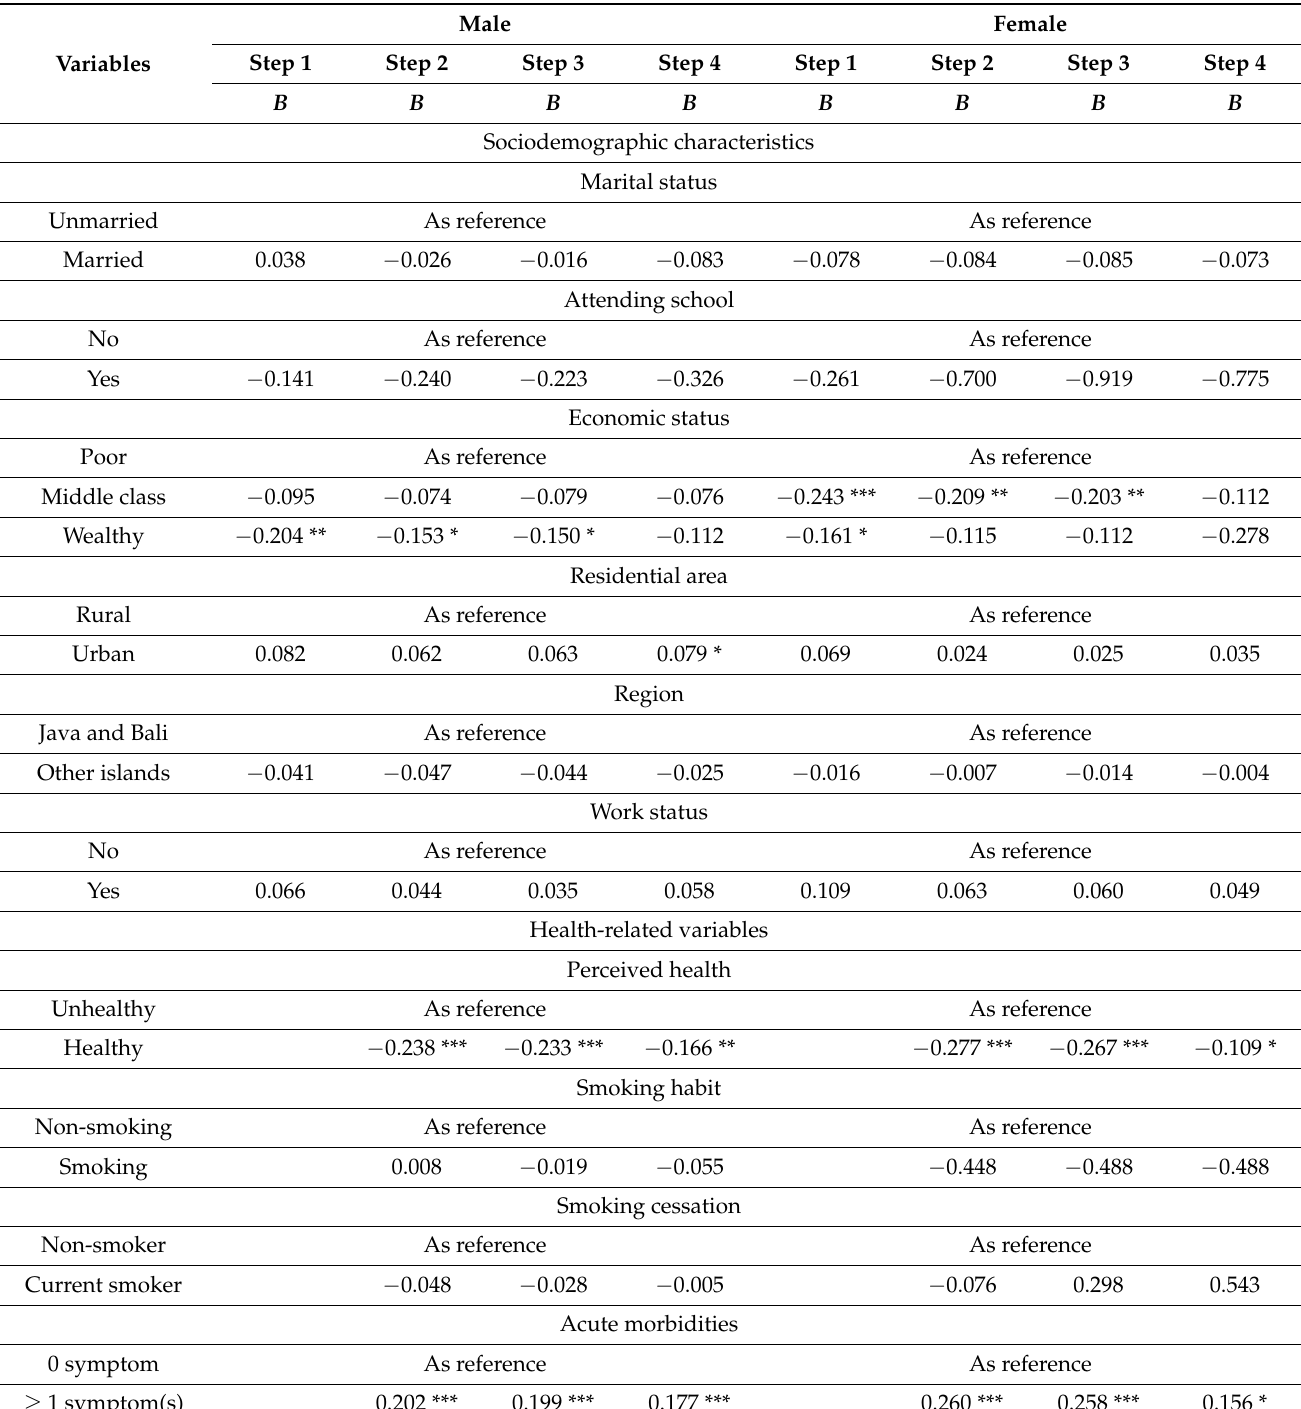
Table 4. Hierarchical multiple linear regression on negative affect by psychosocial and health-related factors in the 15–18 y age group based on